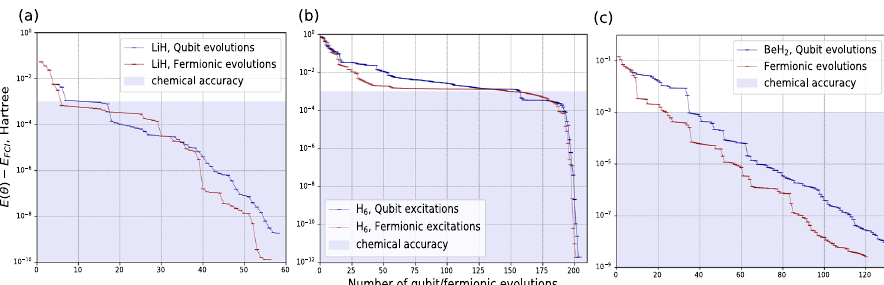
Fig. 4 Comparison of the qubit and fermionic-excitation evolutions at large bond distances. The three sub fi gures present energy-convergence plots for the ground states of: a LiH, b H 6 , and c BeH 2 , in the STO-3G orbital basis set, at bond distances of r Li − H = 3 Å , r H − H = 3 Å , and r Be − H = 3 Å , respectively. The blue plots are obtained with the QEB-ADAPT-VQE for n = 1 and step 5 not implemented. The red plots are obtained with the fermionic-ADAPT-VQE